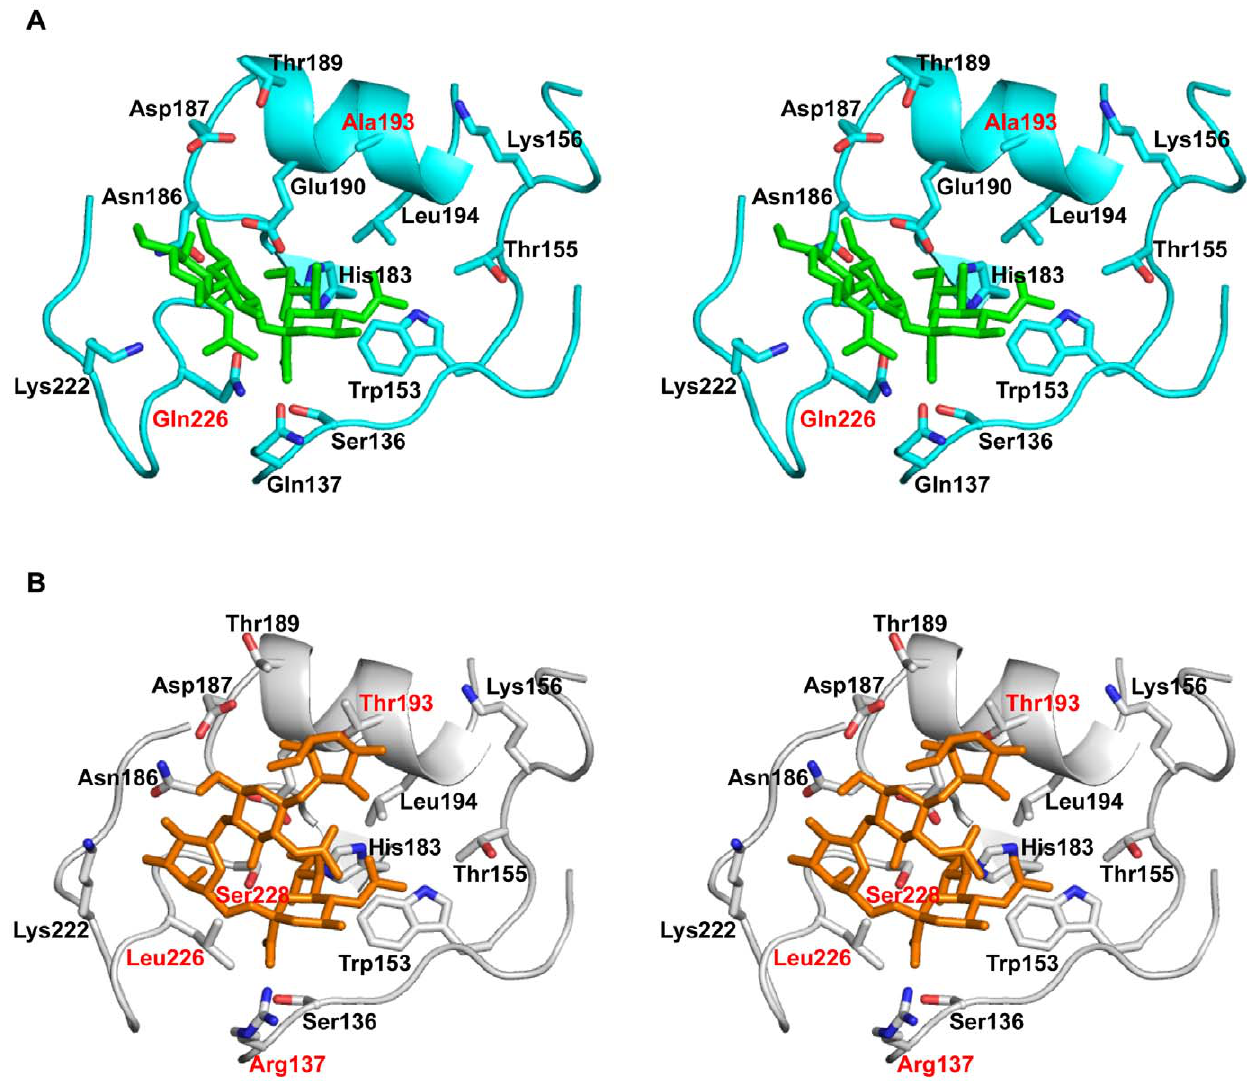
Figure 4. Homology-based structural model of HA-glycan receptor complexes. A , stereo view of the RBS (shown as cartoon in cyan ) of CkPA04 HA – avian receptor structural complex constructed using co-crystal structure of A/Chicken/NY/91-avian receptor (PRB ID: 2WR2) as a template. The resolved coordinates of the avian receptor (Neu5Ac a 2 R 3Gal b 1 R 3GlcNAc) are shown using a stick representation (in green ). B , stereo view of RBS (shown as cartoon in gray ) of Alb58 HA – human receptor complex constructed using co-crystal structure of A/Singapore/1/57– human receptor (PDB ID: 2WR7) as the template. The resolved coordinates of the human receptor (Neu5Ac a 2 R 6Gal b 1 R 4GlcNAc b 1 R 3Gal) are shown using a stick representation (in orange ). The side chains of the key residues involved in interaction with glycan receptor are shown and labeled. The residues in the RBS that differ between CkPA04 and Alb58 HA are labeled in red .